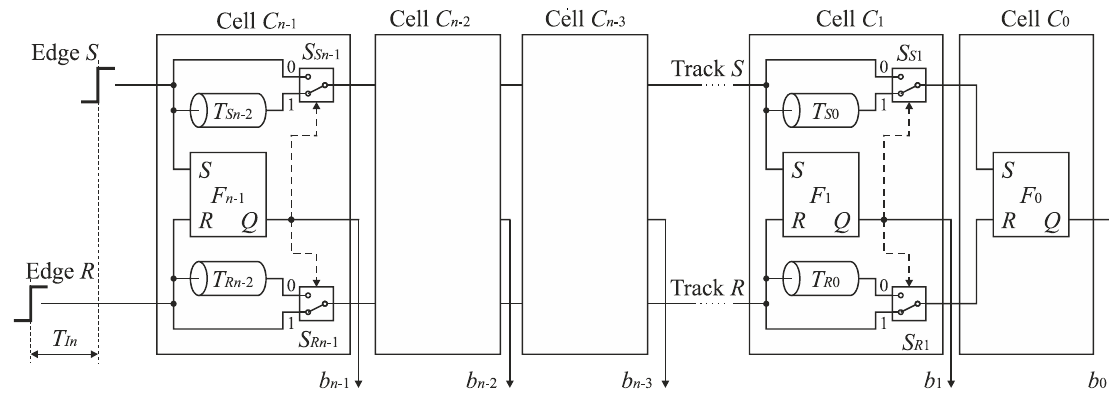
Figure 12. Basic n -bit feedforward SA-TDC architecture for bipolar input time interval T In .